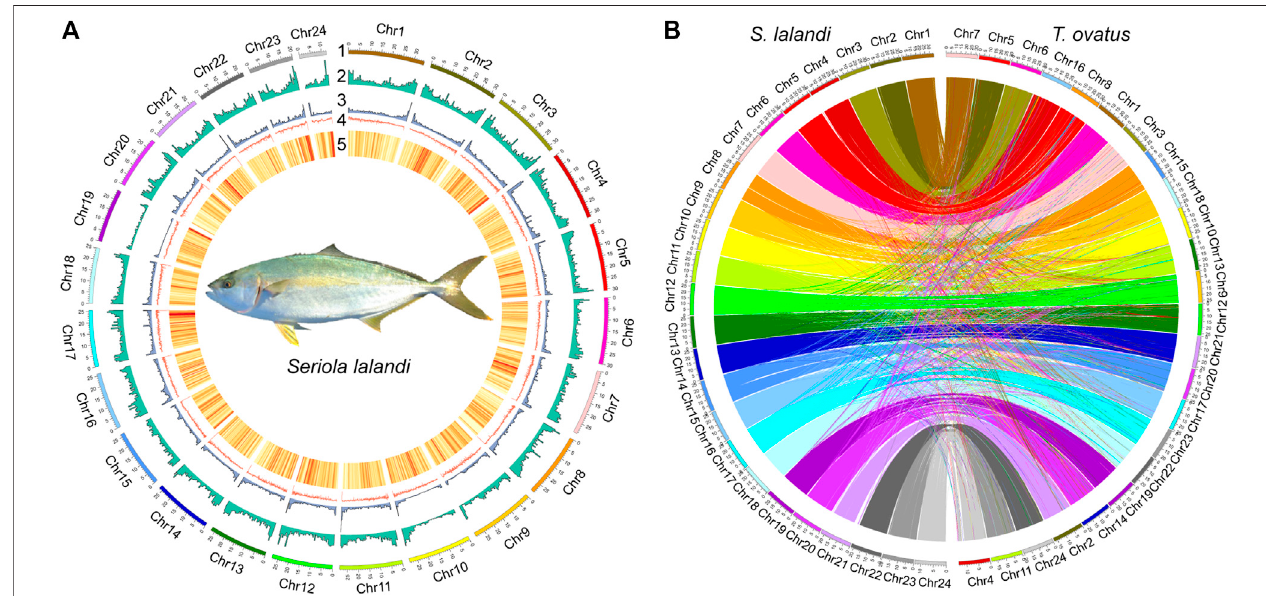
FIGURE1| Genomeassemblyandcomparison. (A) Circosgraphofgenomestatistics.Genomicfeatures.Fromoutertoinnercircles:1,representschromosomes; 2, distribution of DNA transposons; 3, distribution of retrotransposons; 4, GC content; 5, gene distribution density; 6, each line joins paralogous genes at different chromosomes.2 – 5aredrawnwith500 Kbslidingwindows. (B) Genomecomparison between S.lalandi and T.ovatus .The S.lalandi chromosomesareontheleft,and the T. ovatus chromosomes are on the